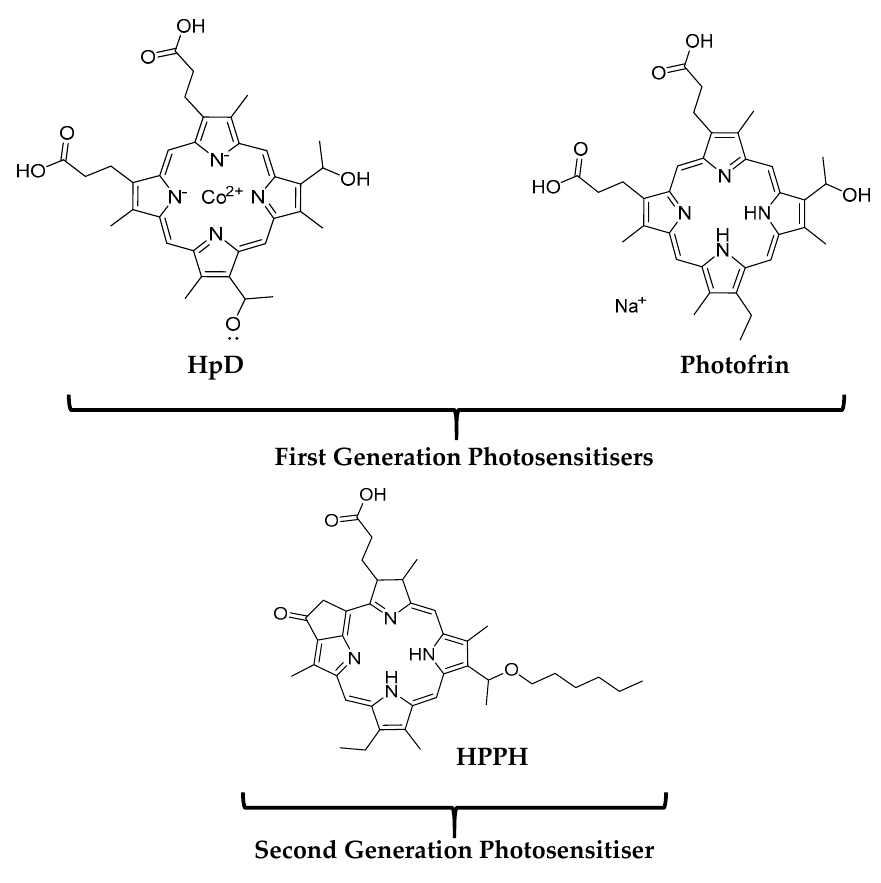
Figure 2. Structures of a few examples of common photosensitisers.